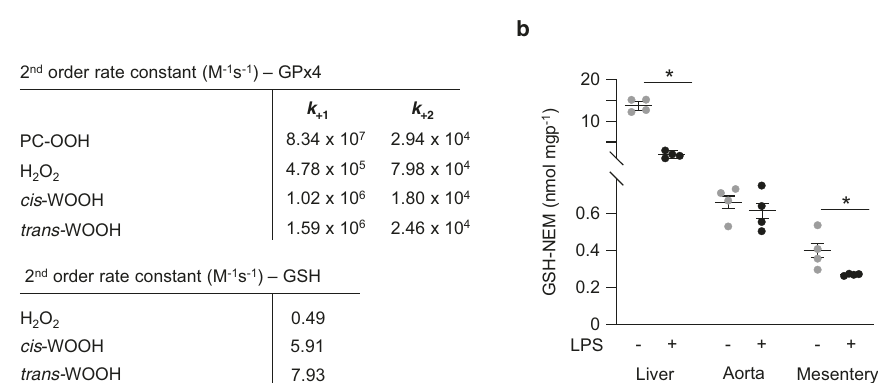
Fig. 2 Reactions of cis - and trans -WOOH with GPx4. a Upper panel shows the second-order rate constants for the reaction of cis - and trans -WOOH with GPx4. k + 1 is the rate constant for the reduction of the hydroperoxide, k + 2 is the cumulative rate constant for the regeneration of the reduced enzyme. The lower panel shows second-order rate constants for the non-enzymatic reaction of cis - and trans -WOOH with GSH. H 2 O 2 and phosphatidylcholine hydroperoxide (PC-OOH) were used for comparison. b GSH content in abdominal aorta and mesenteric arteries from naïve mice and animals treated with lipopolysaccharide (LPS). Summary data are shown as mean ± SEM, n = 4 independent experiments. Statistical analysis was performed using two-tailed Mann – Whitney tests; * p ≤ 0.05. Exact p -values are as follows: p = 0.0286 (liver, naïve vs LPS treated) and p = 0.0286 (mesentery, naive vs LPS treated). Source data are provided as a Source data fi 0.4 nmol mgp − 1 GSH, respectively, compared with ~15 nmol mgp − 1 GSH in liver (Fig. 2b). Treatment with LPS signi fi cantly